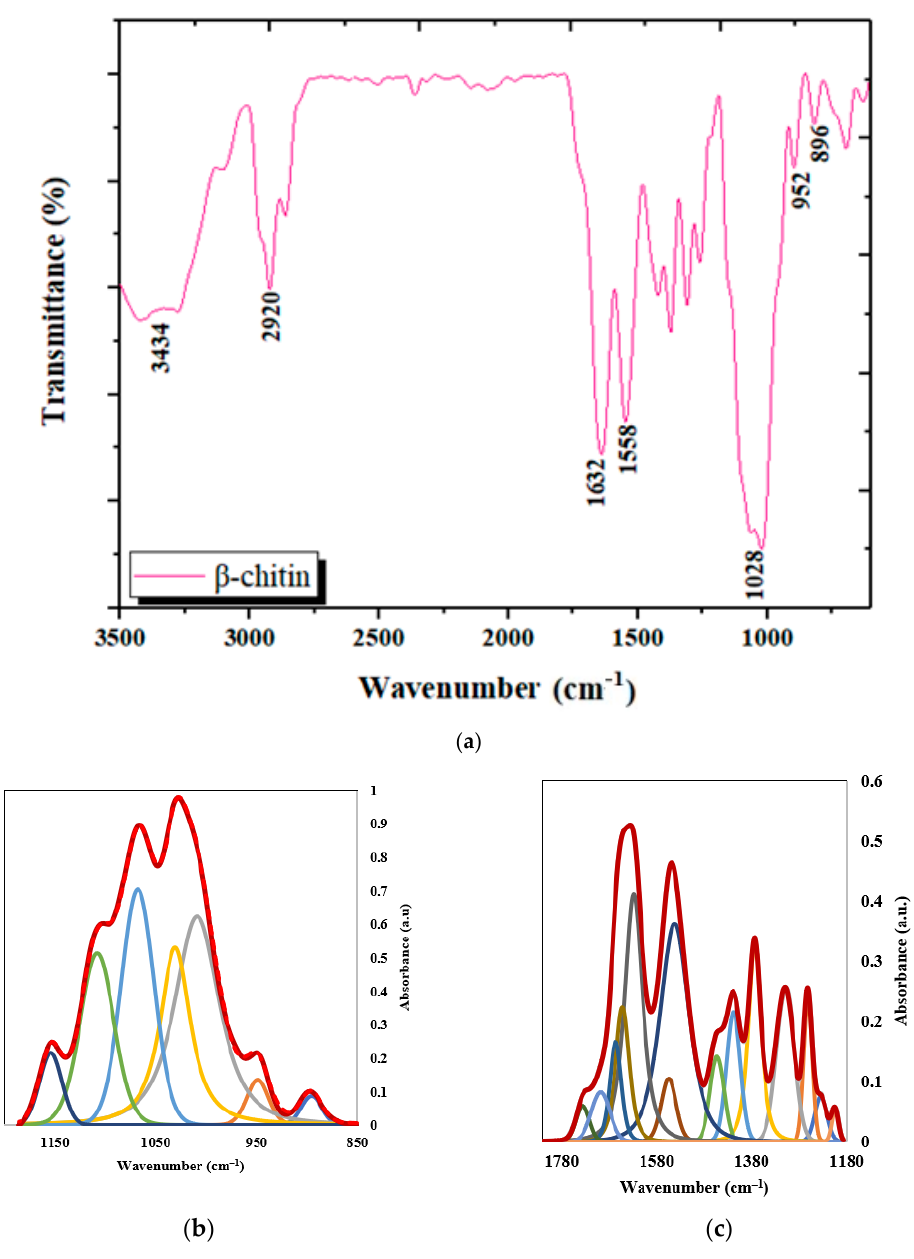
Figure 7. ( a ) The FT-IR spectrum of the chitin fraction separated from the cuttlefish bone deproteinization liquid extract; ( b , c ) deconvolution of two spectral domains of interest in the identification of chitin derivatives.